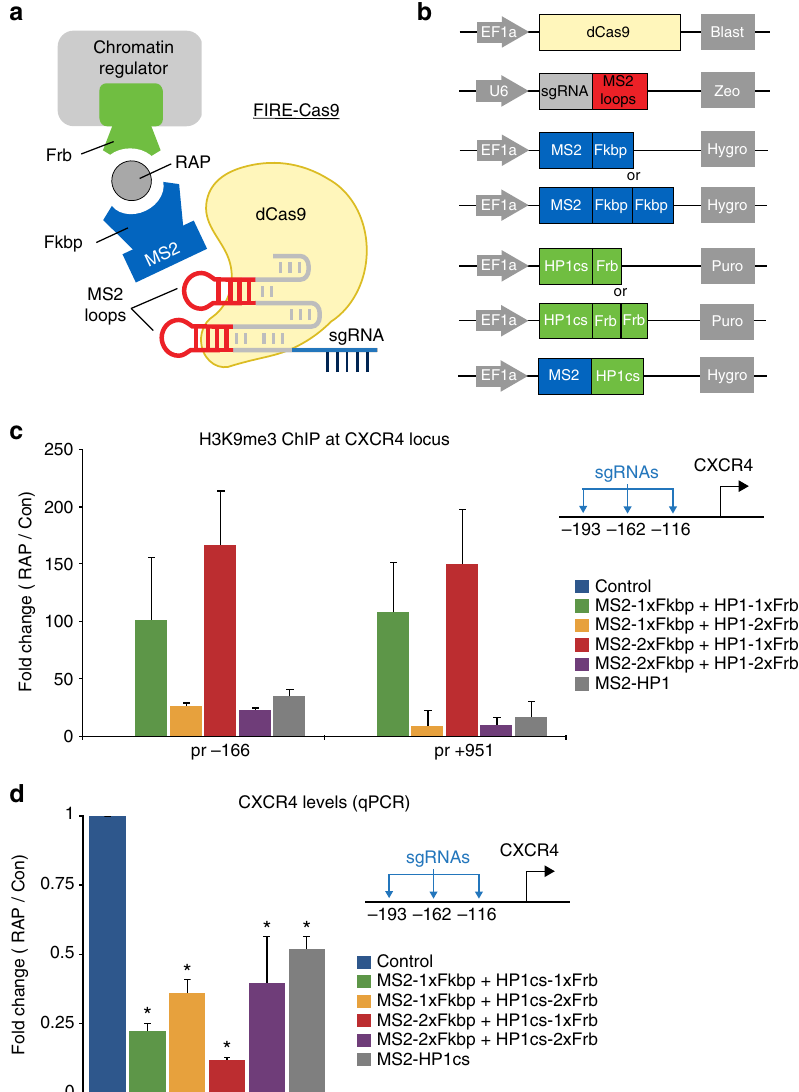
Fig. 1 Inducible heterochromatin complex recruitment silences target gene expression in HEK 293 cells. a Schematic representation for rapid and reversible recruitment of chromatin regulators to speci fi c genomic loci by FIRE – Cas9. b Lentiviral constructs used for dCas9, sgRNA-MS2, MS2-Fkbp (1x or 2x) and HP1cs-Frb (1x or 2x), or MS2-HP1cs expression in HEK 293 cells. Lentiviral integration is selected for with four unique resistance genes. c H3K9me3 ChIP analysis at the CXCR4 locus ( − 166 bp and +951 bp from TSS) after 5 days of RAP treatment to induce HP1cs recruitment. Fold changes represent RAP/Control (Con: untreated, no RAP) in respective cell lines except for direct fusion experiment where fold change represents MS2-HP1/MS2-Fkbp recruitment (both untreated, no RAP). n = 3; error bars s.e.m. d CXCR4 expression levels measured by qPCR after 5 days of RAP treatment to recruit HP1cs. n = 3; error bars s.e.m. p <